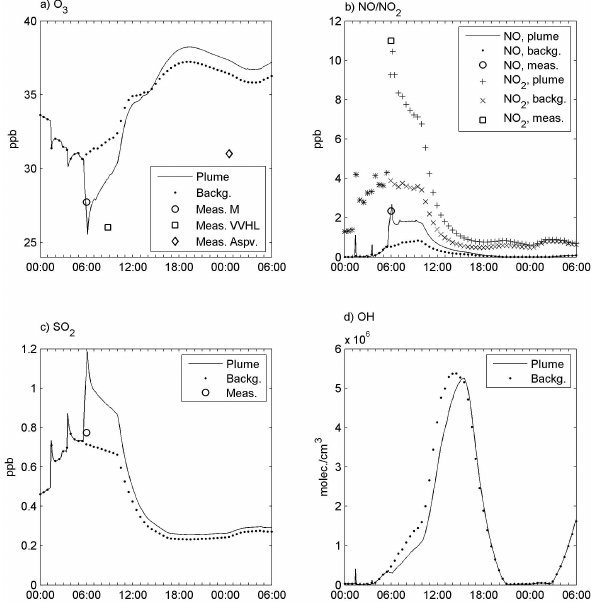
Fig. 6. Modeled total particle number concentration (PN) (a) 3h downwind of Malm¨o, (b) 12h downwind of Malm¨o and (c) 24h downwind of Malm¨o, in the whole model domain (20km in the horizontal and 2km in the vertical direction) perpendicular to the air mass trajectory. Vavihill (VVHL) is position in the center of the horizontal model domain 3h downwind of Malm¨o.